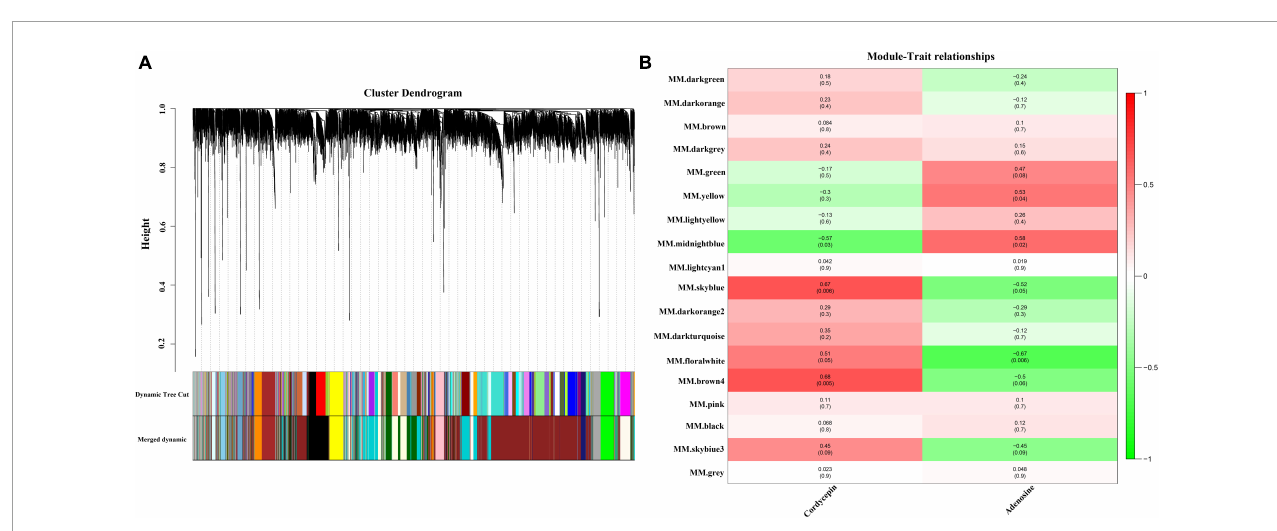
FIGURE3 Weighted gene co-expression network analysis (WGCNA) of the significantly changed transcripts. (A) Module level clustering diagram, divided into 18 modules (B) cordycepin and adenosine content correlation